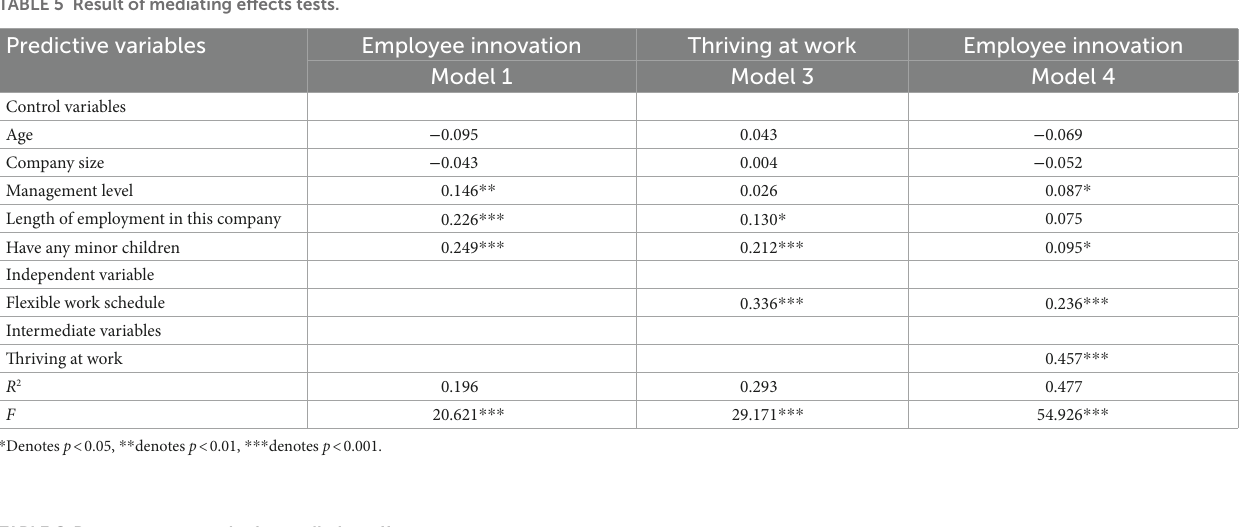
TABLE 6 Bootstrap test results for mediation